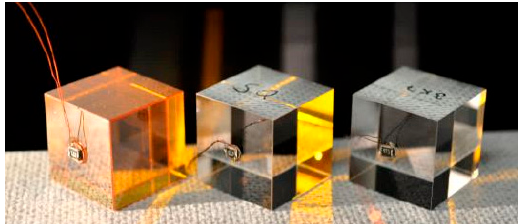
Figure 2. Samples of different materials for surface/coating absorption calibration.